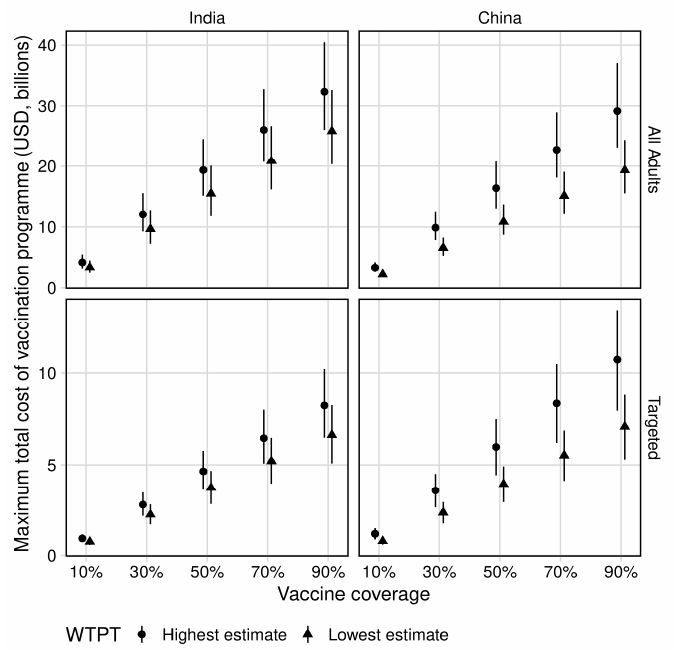
Figure 1. Maximum total vaccine programme cost. Top panels represent all-age vaccination (adults ≥ 10 years); bottom panels represent targeted vaccination (ages 50–59 in India and ages 60–69 in China). WTPT = willingness to pay thresholds per Ochalek et al. [9], estimated at $264 and $363 per DALY averted in India (lowest and highest estimates, respectively) and $3650 and $5669 per DALY averted in China (lowest and highest estimates, respectively). Costs discounted to 2018 values.